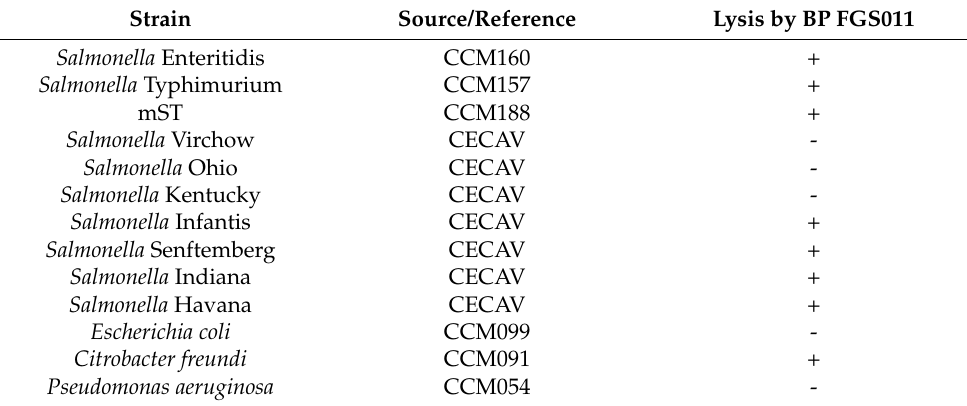
Table 1. The lytic spectrum of FGS011 against 13 bacterial strains from 4